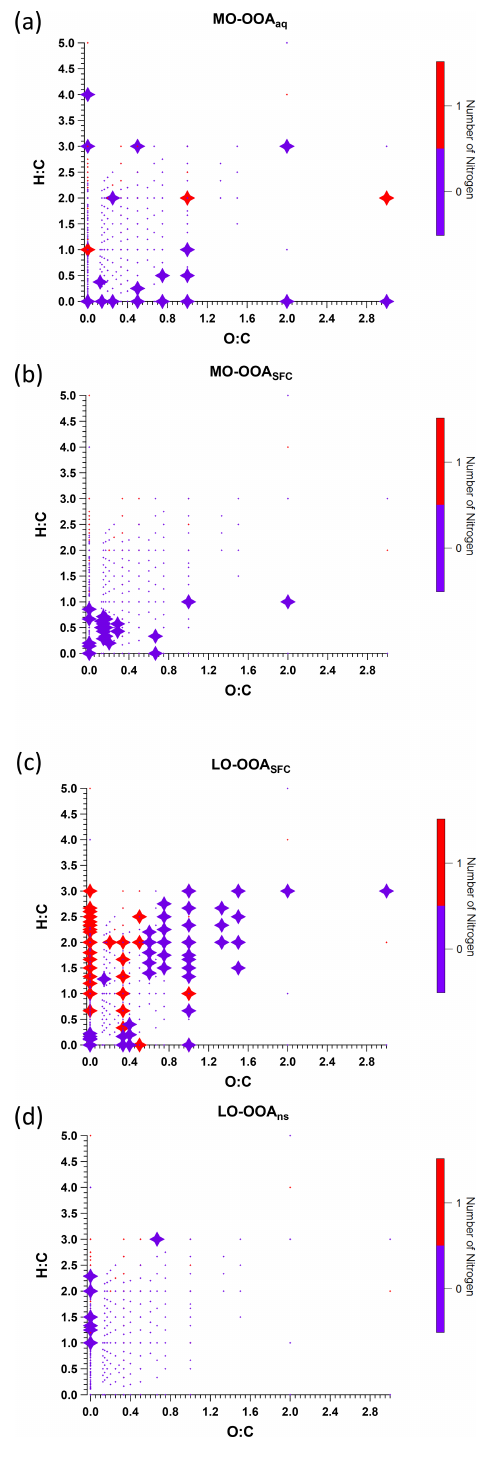
Figure 9. Van Krevelen plot of AMS factor mass spectra for (a) MO-OOA aq , (b) MO-OOA SFC , (c) LO-OOA SFC , and (d) LO- OOA ns , coloured by the number of nitrogen atoms. Large symbols denote ions with median z score ≥ 1.5, and small symbols denote median z score < 1.5 for accepted runs from bootstrap